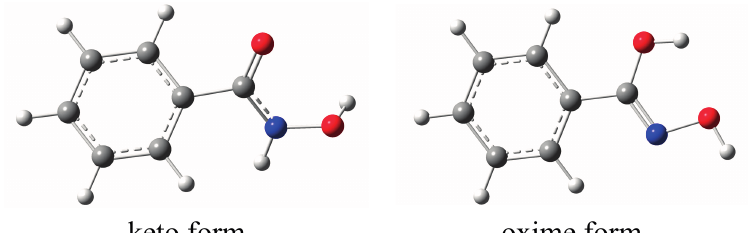
Figure 6. Two tautomers of hydroxamic acids.